Question: Draft a figure caption describing what is shown.
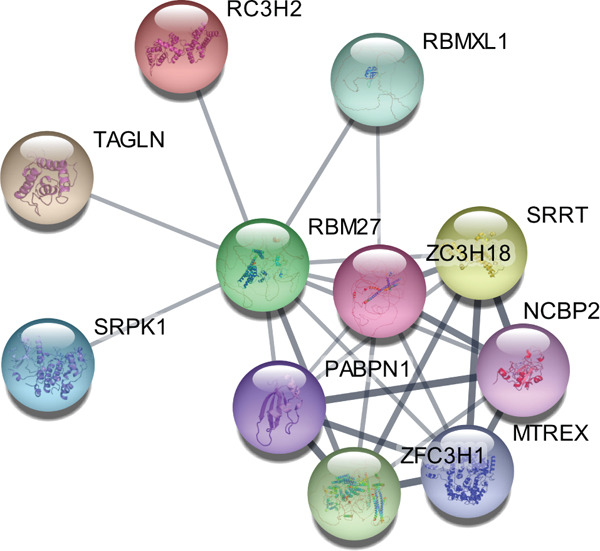
Answer: PPI network enrichment analysis. (a) The PPI network was built based on PPI pairs identified by the STRING dataset. (b) String network protein interaction score. (c) Expression profiles of 10 genes functionally associated with RBM27 in HCC from TCGA. (d–k) Correlation heatmaps demonstrating coexpression patterns betweenRBM27 and its associated genes. (l) GO enrichment analysis was used to analyze the proteins that interacted with RBM27. (m) Protein docking sites were predicted by Alfhafold3 website.